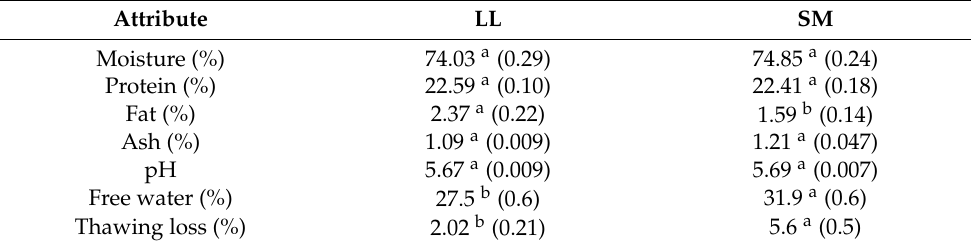
Table 1. Characteristics of raw bovine muscles longissimus lumborum (LL) and semimembranosus (SM) (mean values and standard error of the mean in